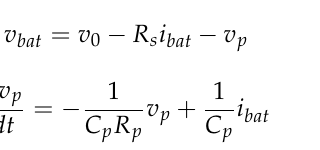
Figure 2. Characteristic of the fuel cell: ( a ) fuel cell polarization curve; ( b ) hydrogen consumption rate with current change.